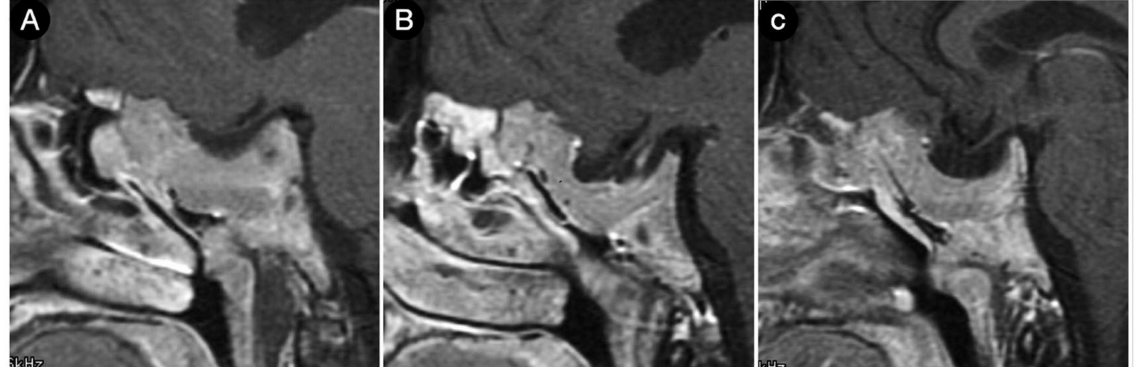
Figure 23. ( A – C ) sagittal T1-weighted contrast-enhanced MRI of the sellar region. Scale bar: 5